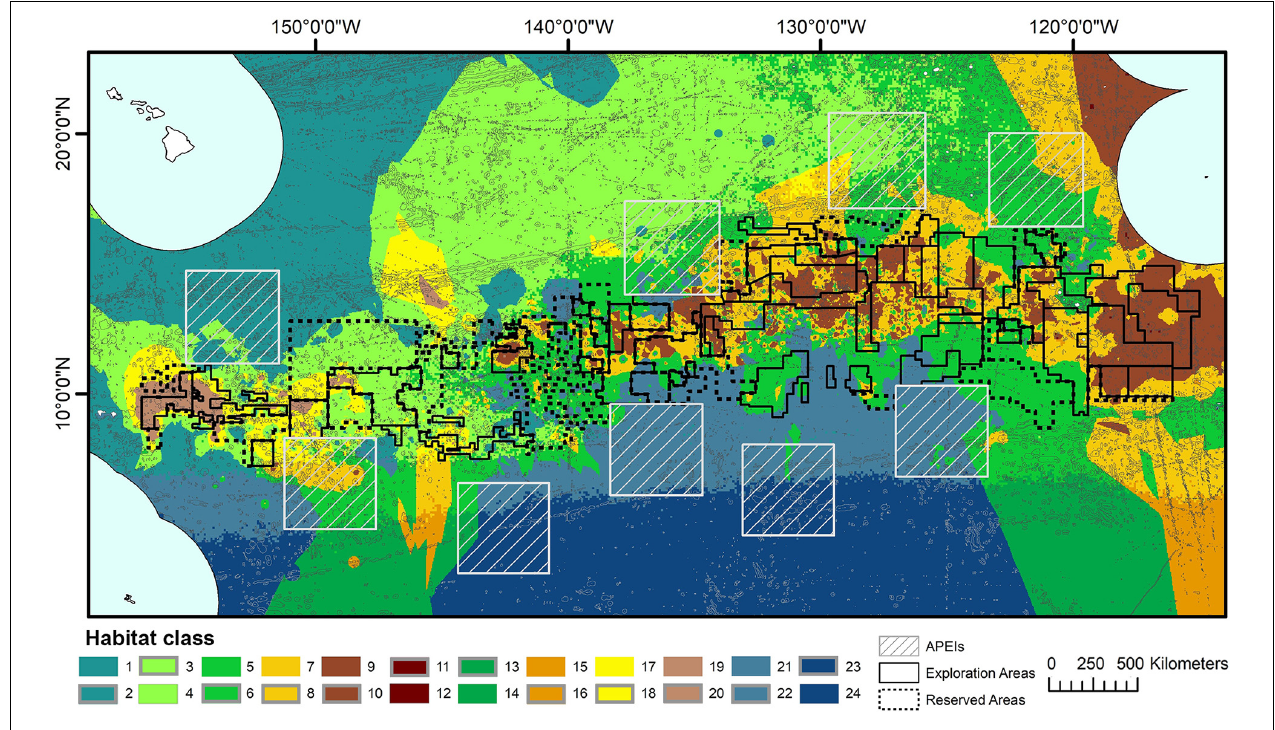
FIGURE 5 | Final 24 habitat classes produced by combining layers of clustered environmental variables. Habitat classes with high nodule abundance are shown in shades of brown, medium nodule abundance in orange/yellow, low nodule abundance in green and very low nodule abundance in blue. Within each nodule abundance group (i.e., very low, low, medium or high), habitat classes with different POC flux to the seafloor are identified by shading (i.e., darkest brown = high nodule abundance, high POC flux; lightest brown = high nodule abundance, low POC flux). Habitat classes with sloping topography are then identified by gray outlines. For example, habitat classes 1 and 2 have the same POC flux and nodule abundance conditions, but differ in topography. Habitat class 1 has very low nodule abundance, low POC flux and is flat, while habitat class 2 has very low nodule abundance, low POC flux and is more